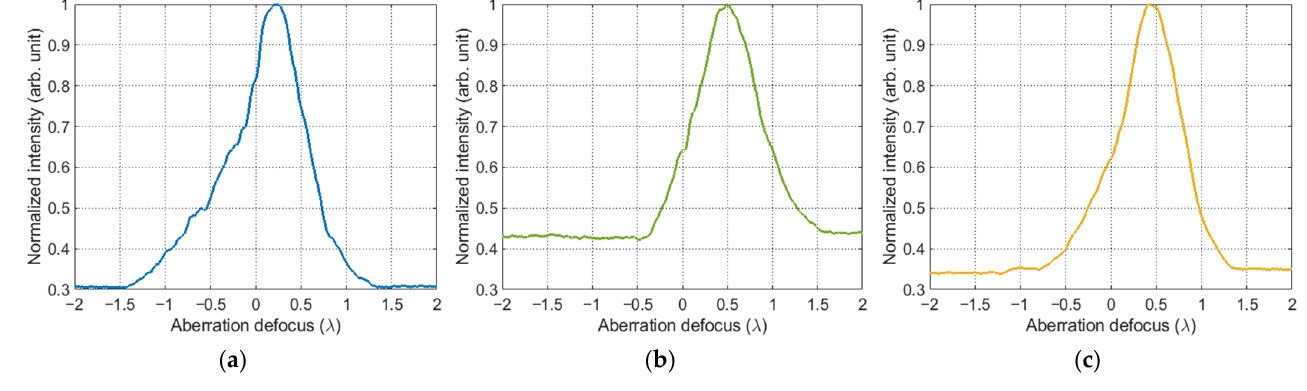
Figure 4. Normalized dependences of the amplitude of the maximum correlation response offset for different wavelength sources: ( a ) λ 1 = 473 nm; ( b ) λ 2 = 532 nm; and ( c ) λ 3 = 561 nm.